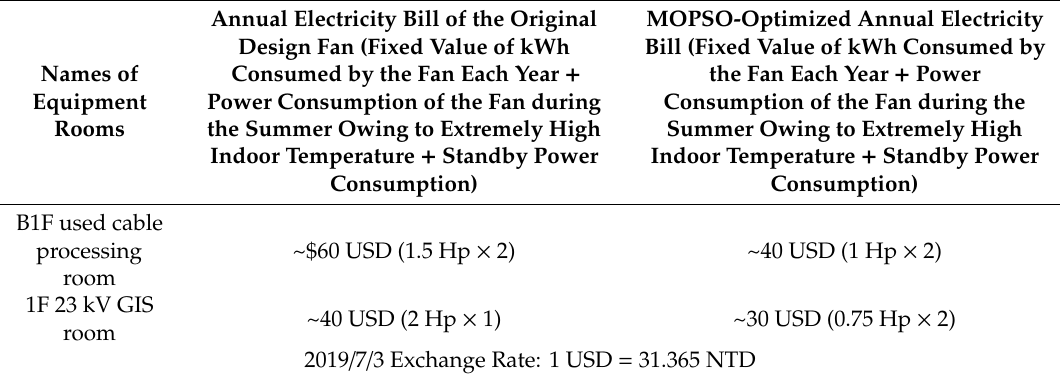
Table 5. Benefit analysis of annual electricity cost reduction in the MOPSO-optimized exhaust fan.